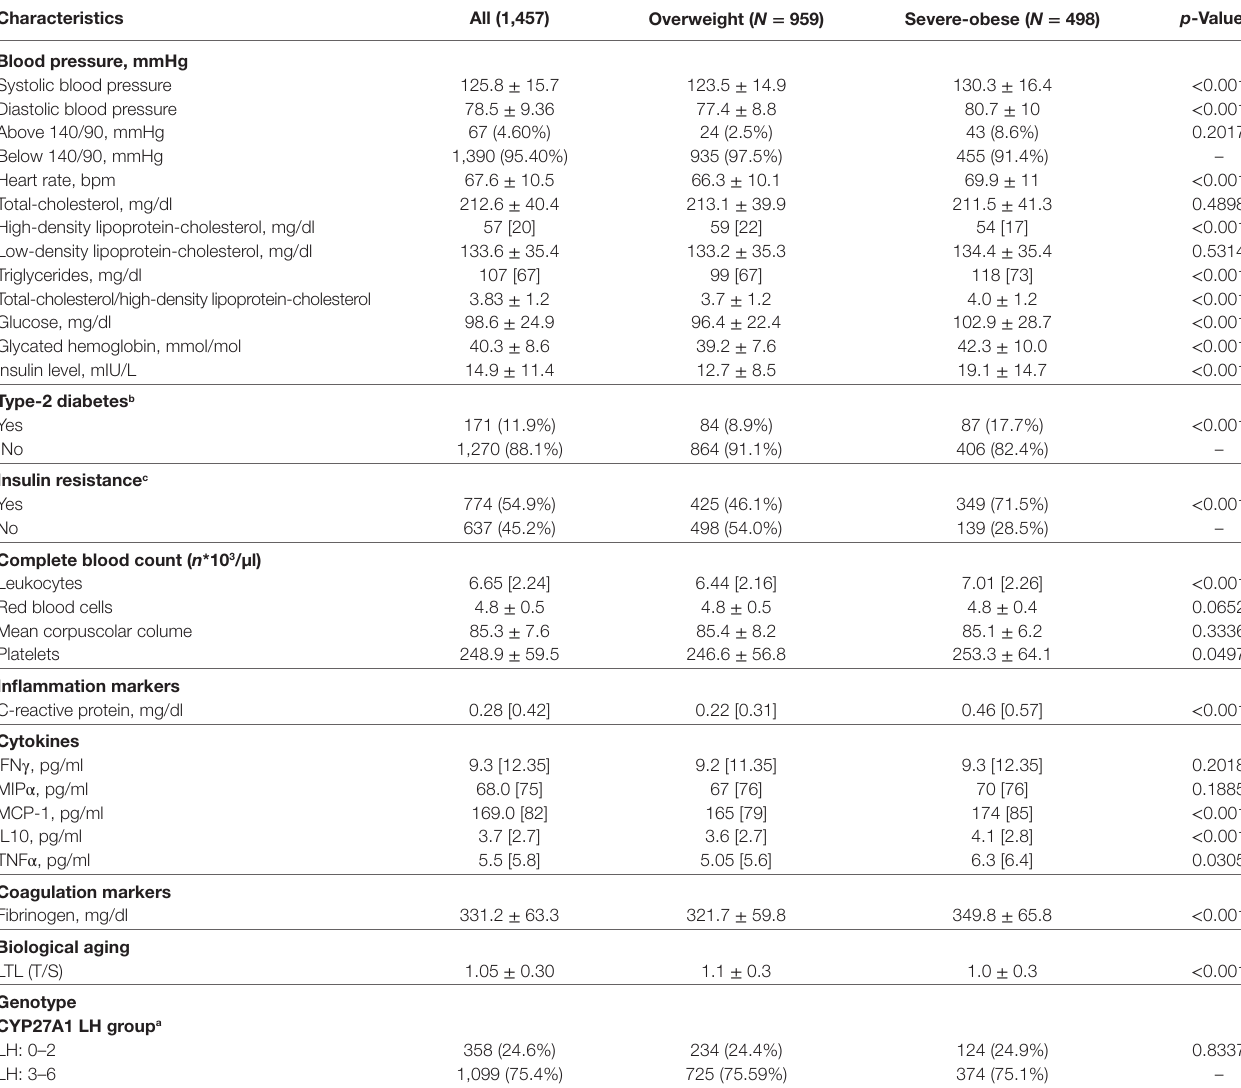
Table 2 shows that quite all CVD risk factors such as classic modifiable risk factors (SBP and DBP), heart rate, lipid profile (Total-C, HDL-C, and triglyceride), glucose homeostasis (insulin resistance and glycated hemoglobin), and novel risk factors such as inflammation markers (leukocytes, CRP, MCP-1, and IL10), coagulation markers (fibrinogen), and biological aging indicator (LTL) were significantly ( p < 0.001) different between overweight and severe-obese individuals. Univariate unadjusted and multivariable sex–age–smoking- adjusted linear regression models are presented in Tables 3 and 4 . TaBle 2 | Cardiovascular disease and type-2 diabetes (T2D) risk factors according to body mass index levels. characteristics